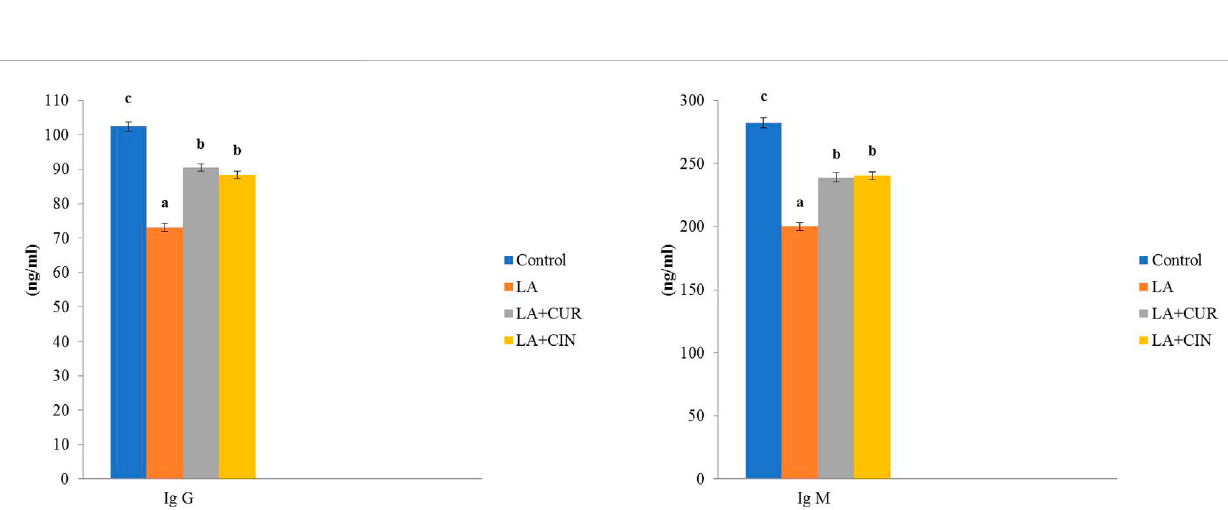
FIGURE 4 Changes of immunoglobulins in different treatment groups compared to the control (mean ± SE). Different superscript letters in each fi gure indicate signi fi cant differences at p <